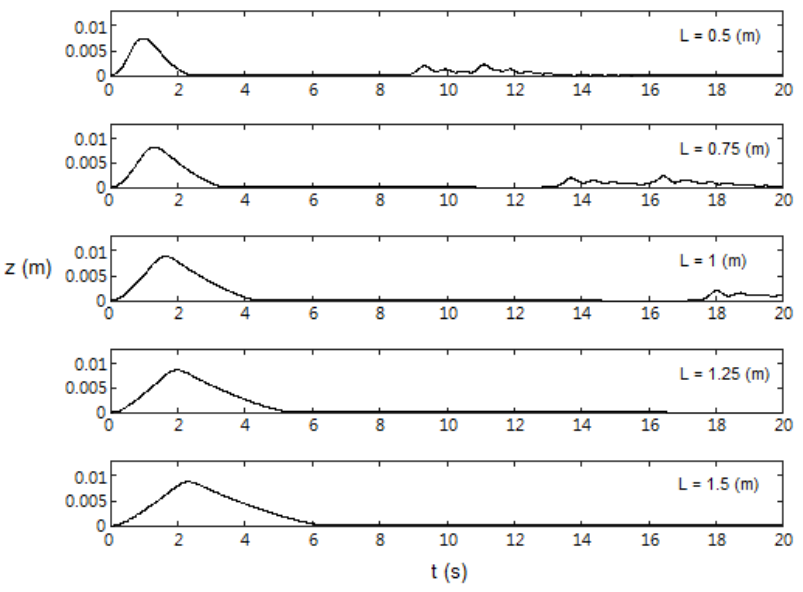
Figure 4. Records of free-surface elevation at the hinge under different wavemaker lengths, L . In all cases, h 0 = 0.03 m, a = 0.02 m, b = 0.5 s, and θ = 0. Upward motion described by (1) is used. Length of the moving bottom (top to bottom): L = 0.5, 0.75, 1, 1.25, 1.5